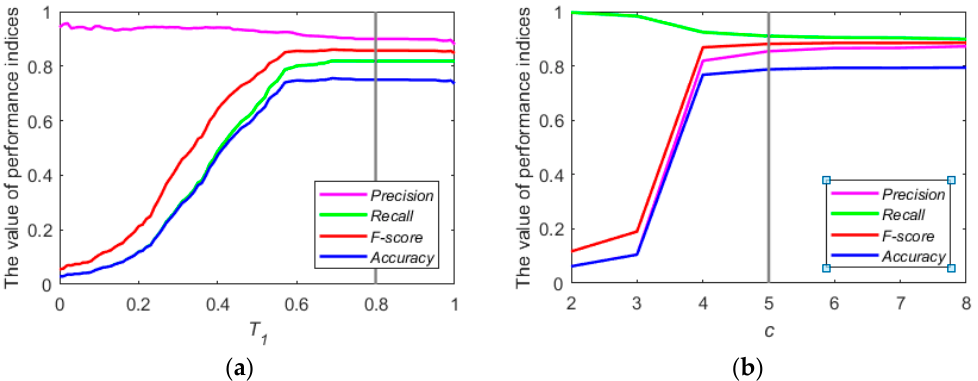
Figure 20. The influence of parameters on the performance of the proposed CDFFCM: ( a ) parameter T 1 , and ( b ) parameter c